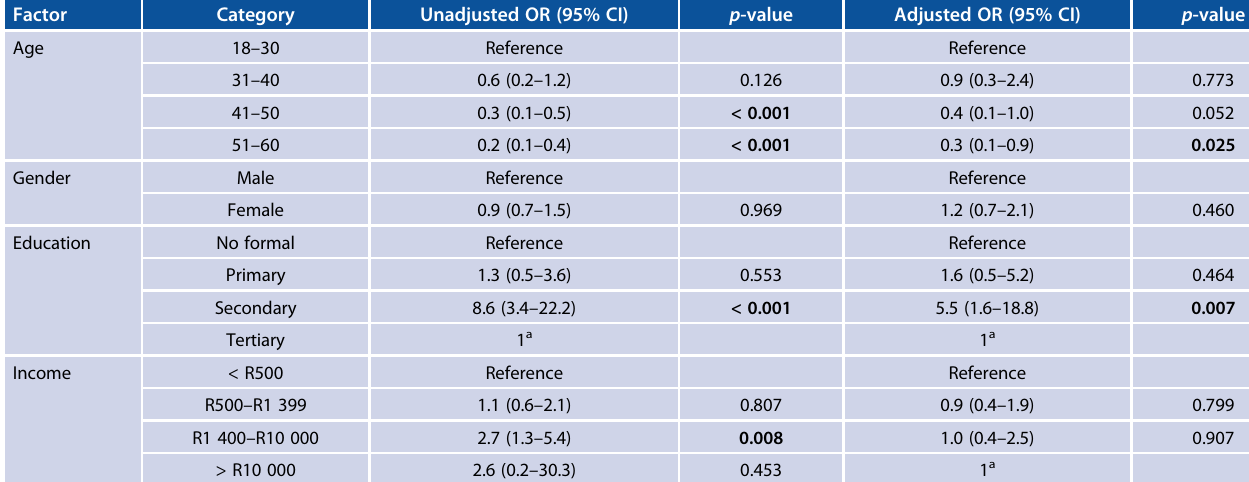
Table 3: Sociodemographic characteristics associated with good knowledge of antibiotics amongst patients at Prince Mshiyeni Memorial Hospital